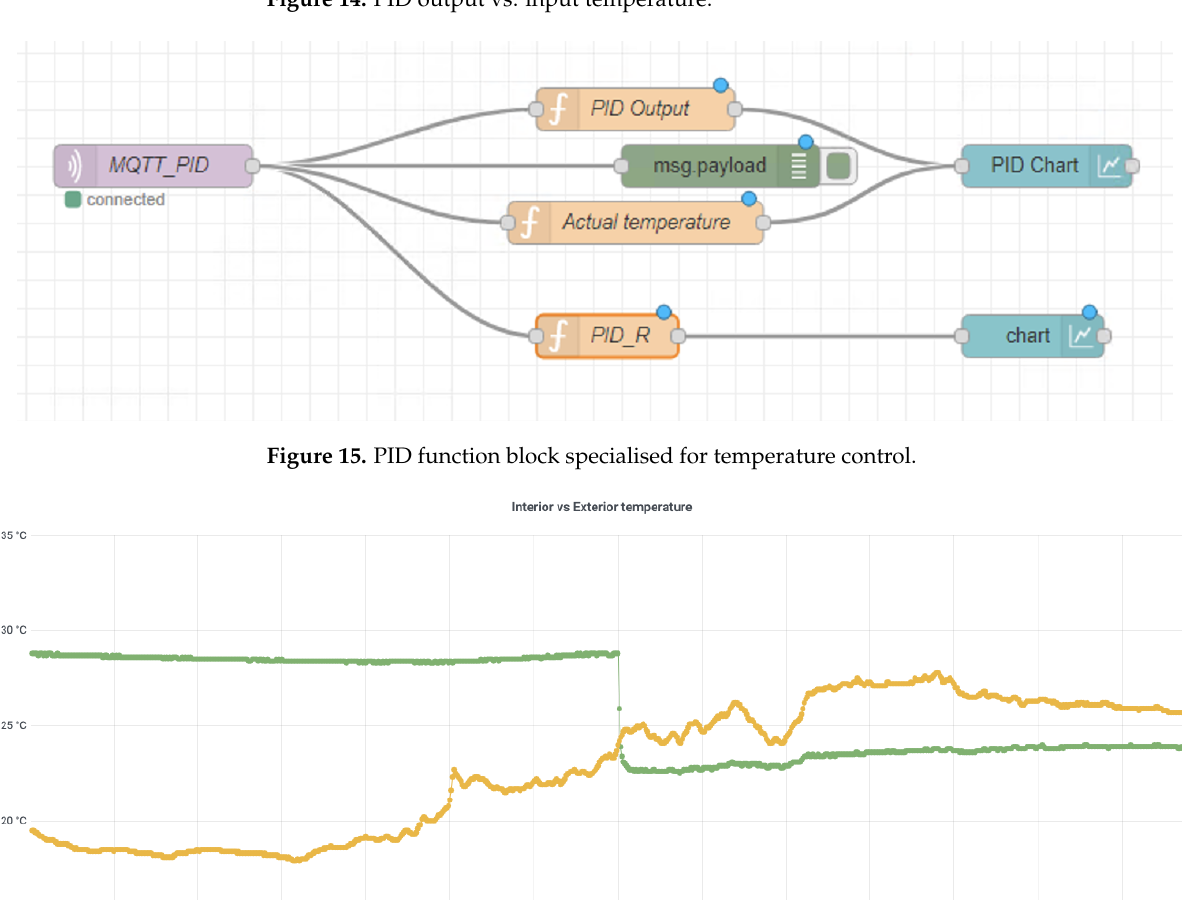
Figure 14. PID output vs. input temperature.